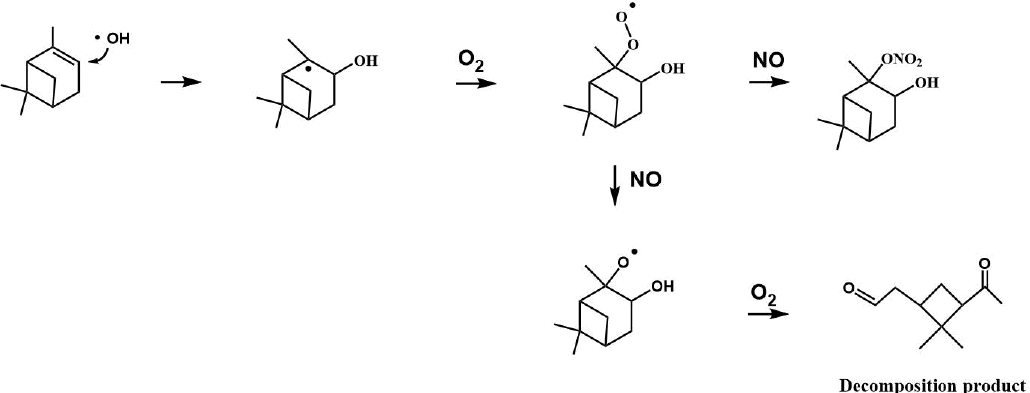
Figure 6. Example reaction pathways of the OH-initiated oxidation of α -pinene in the presence of NO x